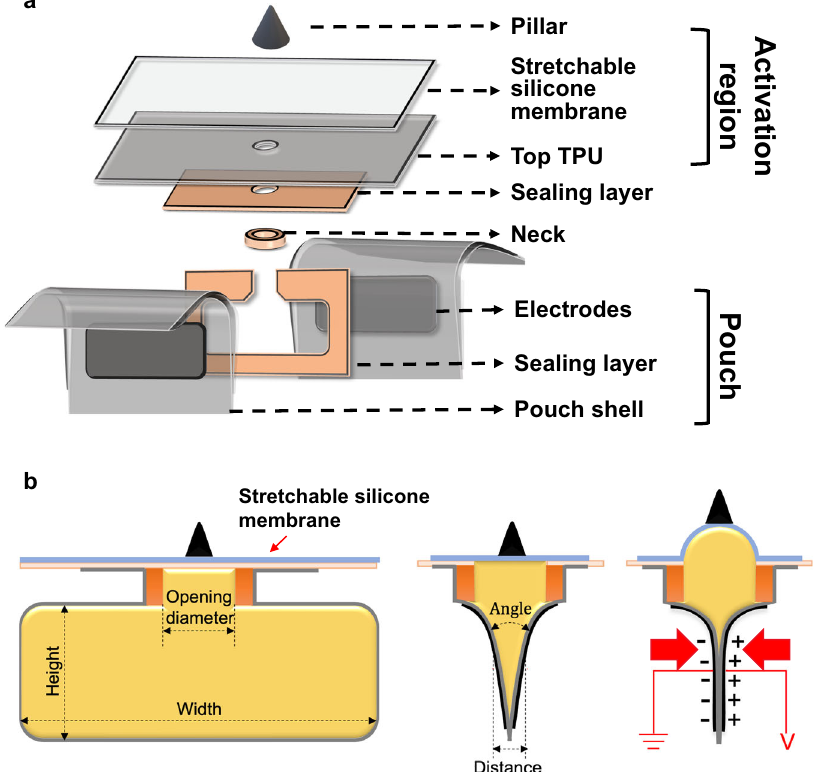
Fig. 2 Schematic illustrations of stretchable pressure-ampli fi ed hydraulic electrostatic actuators. a Exploded view of the actuator. b Working principle of the